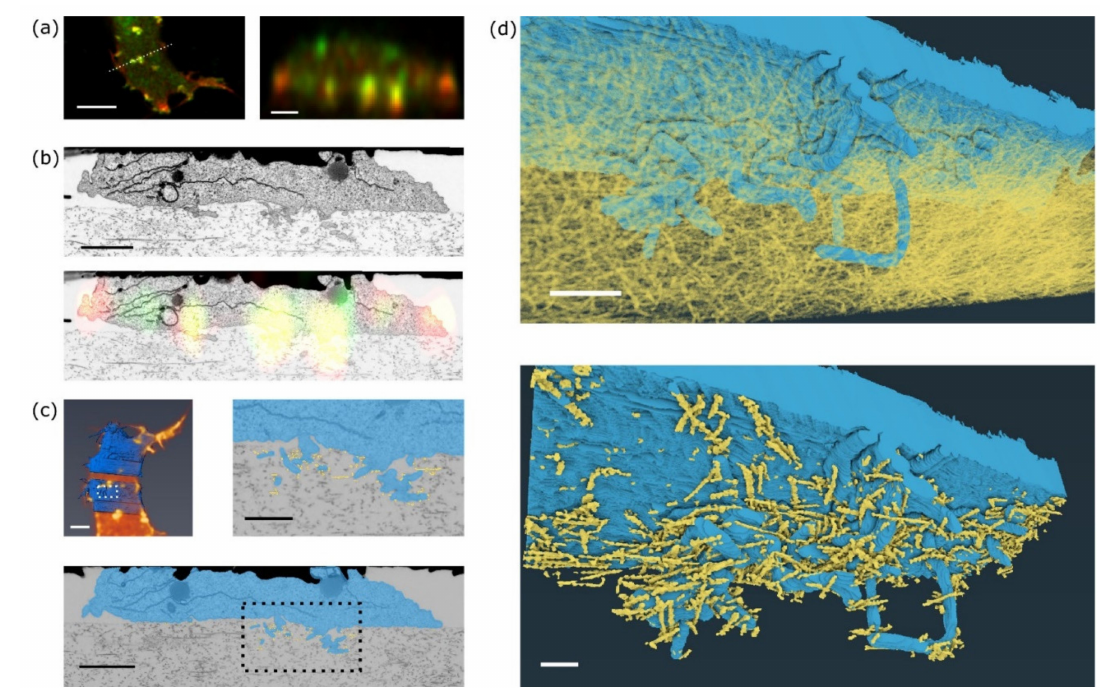
Figure 4. Data correlation and segmentation of invadopodia. ( a ) Position (left) and single xz slice (right) used for correlation between EM and LM data. Scale bars 10 µ m (left), 2 µ m (right). ( b ) Top: EM slice from FIB-SEM used for EM and FM correlation. Bottom: Overlay of LM and EM single slice showing overlap between invadopodia resolved in detail (EM) and localisation of MT1-MMP-GFP signal from live-cell imaging. Scale bar 2 µ m. ( c ) Top left: 3D overlay of FIB-SEM data after alignment and segmentation (in blue) with actin-fluorescence (orange). Top right: Detailed view of segmentation of selected invadopodia (blue) growing into collagen fibres in direct contact with them, shown in yellow. Bottom: Overview of shape segmentation in a single slice from FIB-SEM. Dotted box marks area of detailed view shown in Top right. Scale bar 5 µ m (top left), 1 µ m (top right), 2 µ m (bottom). ( d ) 3D projection of a detailed segmented invadopodium (cell shape in blue). Top: invadopodium (blue) inside a collagen meshwork (yellow). Bottom: collagen fibres in direct contact with cellular surface (yellow). Scale bar 1 µ m (top), 500 nm